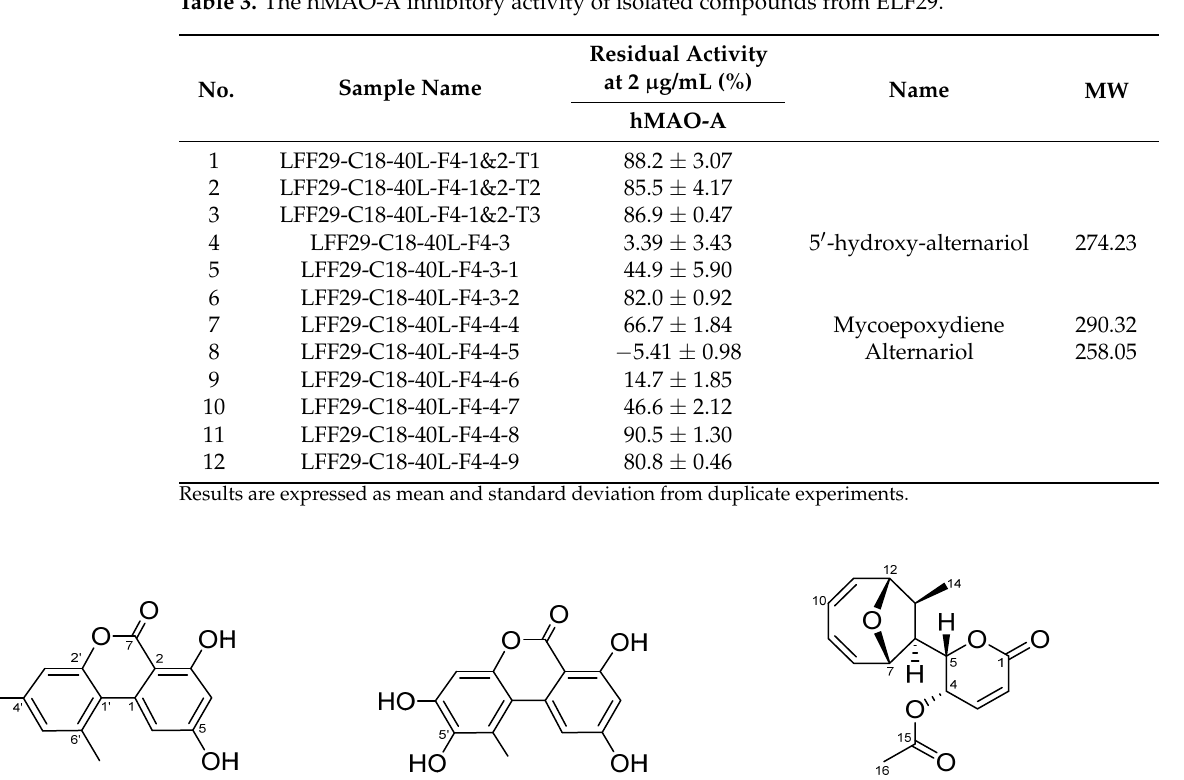
Figure 1. Residual activity of the ELF29 extract and nine fractions collected from the C18 column chromatography. Residual activities of the extract and the fractions were measured at 20 and 2 µg/mL, respectively. Table 3. The hMAO-A inhibitory activity of isolated compounds from ELF29.